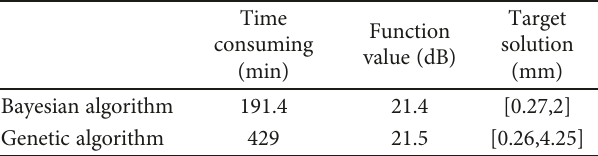
Table 4: Comparison of the antenna skin optimization results.